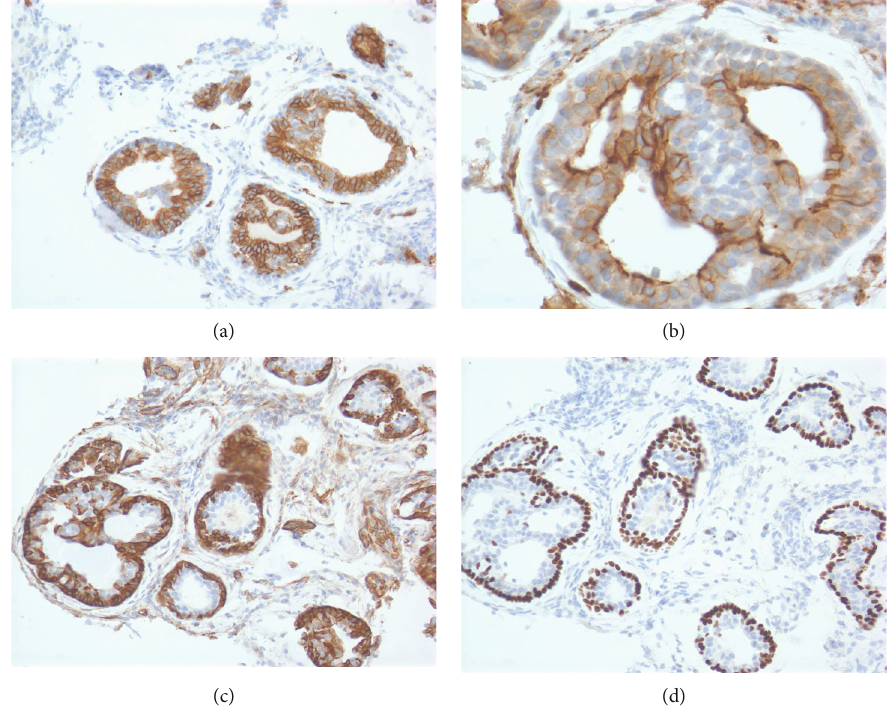
Figure 3: (a) C-kit (100x), (b) CEA (400x), (c) SMA (200x), and (d) P63 (200x), respectively. The luminal epithelial cells of the tumor are positive for C-kit and CEA; the abluminal myoepithelial cells of the tumor are positive for SMA and